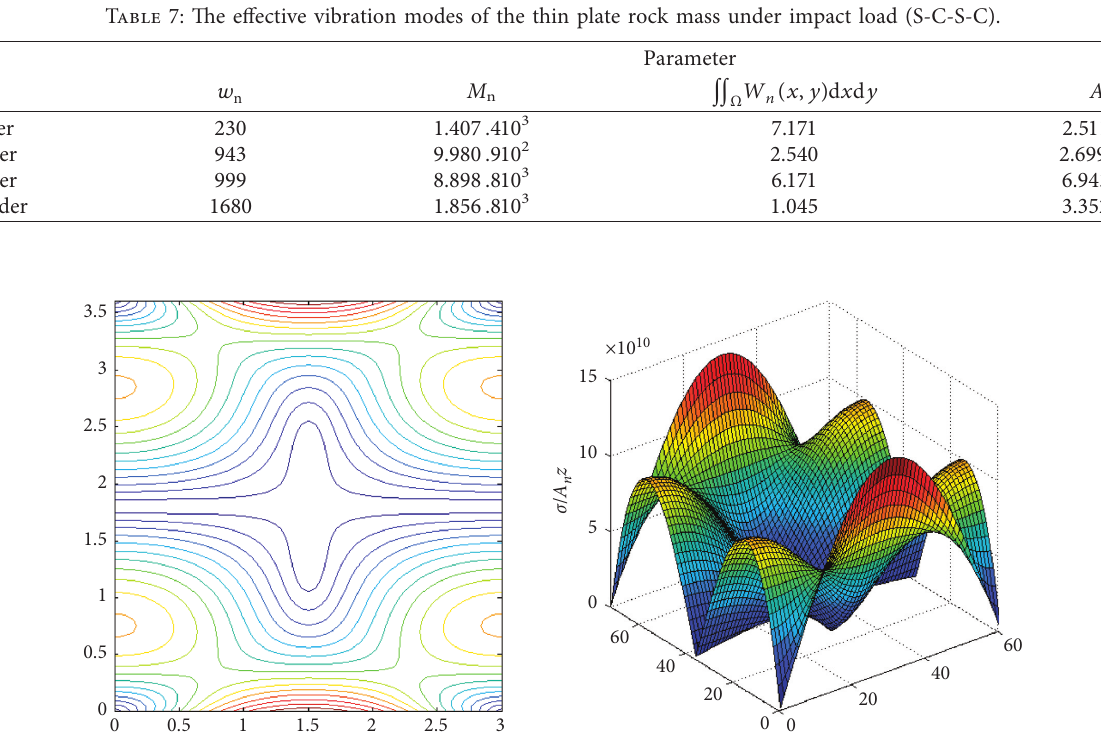
Figure 2: The maximum shear of the 1 st order mode (S-C-S-C).